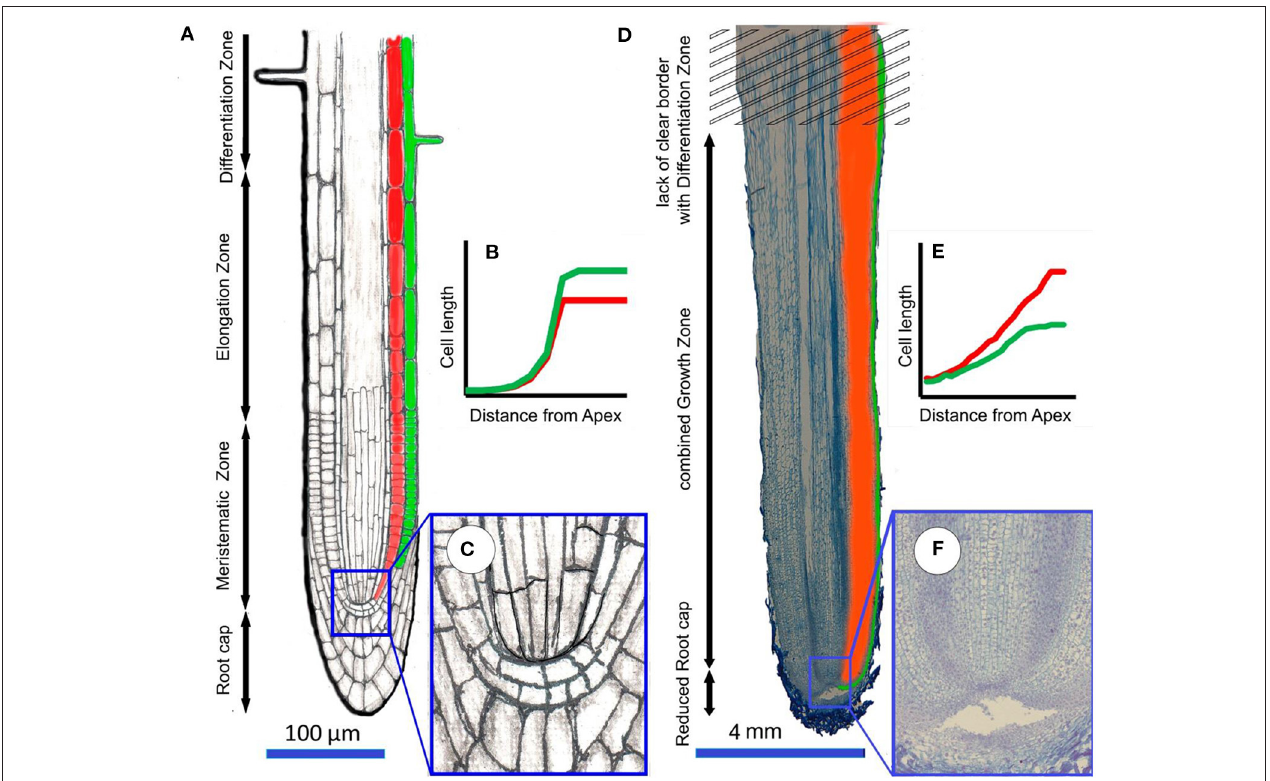
FIGURE 7 | The difference in the organization of the processes of growth of belowground roots (for example Arabidopsis ) and aerial roots (for example Cattleya skinneri ). The subterranean root (A) is usually relatively thin ( ≤ 1mm), has a well-developed root cap and clearly localized zones of meristem, elongation and differentiation, which wass diagnosed by the appearance of root hairs; (B) the average cell length increases exponentially from meristem to elongation zone, rhizodermal cells are loner than cortex cells; (C) detail of closed meristem. In the aerial root (D) , which is much thicker than the belowground subterranean root ( ≥ 1mm), the reduced cap, meristem, and elongation zones are merged into a single growth zone, which does not have a clear boundary with the differentiation zone. Root hairs do not develop in the differentiation zone; (E) the average cell length increase linearly over a long distance, while cell growth can be accompanied by cell divisions. Cortex cells that have completed growth are longer than rhizodermal cells; (F) detail of open meristem.